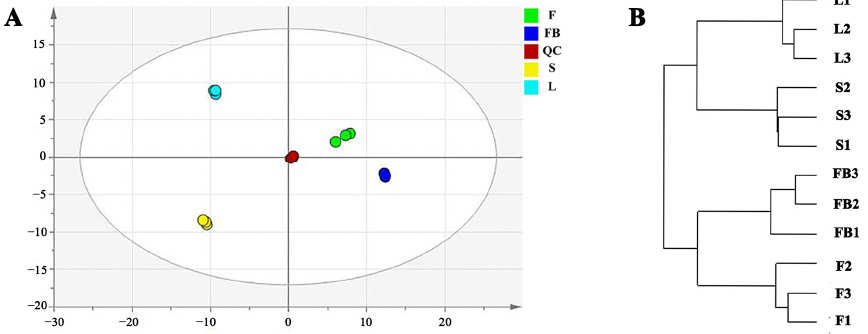
Figure 3. Analysis of metabolic variation in different tissues of LJT. ( A ) the score plot of PCA anal-ysis. ( B ) hierarchical cluster analysis of different tissues of LJT.